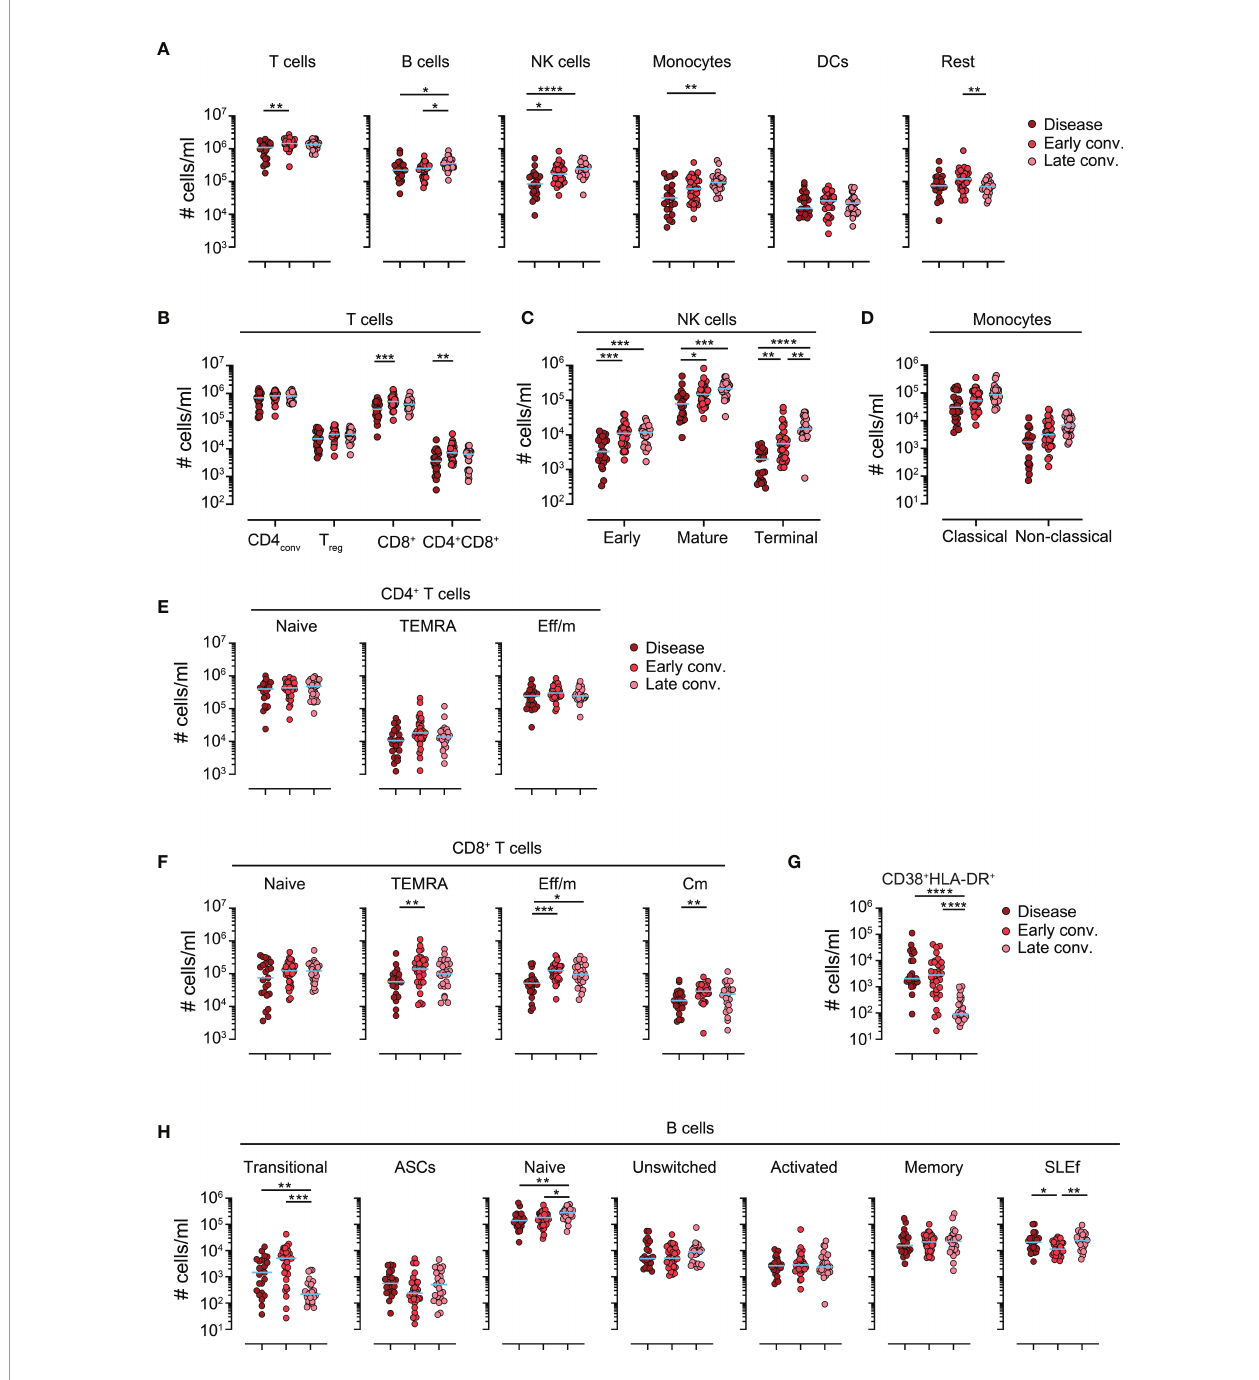
FIGURE 1 | Leukocyte responses in convalescing patients. Absolute cells numbers per ml of blood in patients with disease, early and late convalescence. (A) Cell numbers of various leukocyte populations. (B) Cell numbers of blood of major T cell subsets (C) Cell numbers of blood of NK cell subsets (D) Cell numbers of blood of monocyte subsets. (E) Absolute cell numbers of memory subsets of conventional CD4 + T cells. (F) Absolute cell numbers of memory subsets of conventional CD8 + T cells. (G) Absolute cell numbers of blood of CD8 + CD38 + HLA-DR + effector memory subpopulation. (H) Absolute cell numbers of B cell subsets. Each dot represents one biologically individual sample taken from one patient. Lines represent median. N (disease)=24; n (early conv.)=32; n (late conv.)=25. Statistics: Kruskal-Wallis multiple comparison test with Dunn ’ s post hoc correction.*p<0.05; **p<0.01; ***p<0.001;